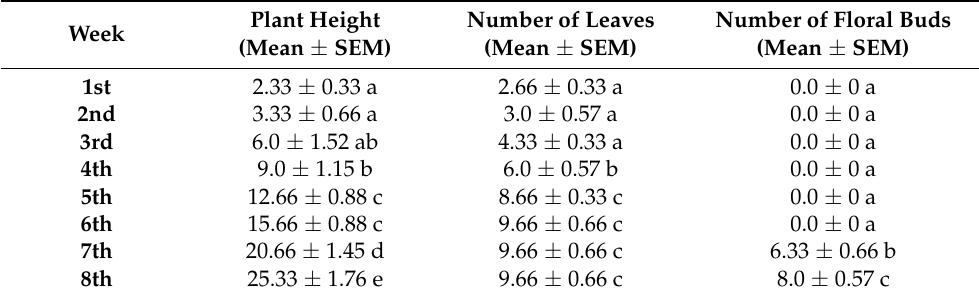
Figure 5. Hardening and acclimatization of in vitro raised plantlets of Aconitum violaceum Jacq. ex Stapf: ( A , B ) three to four week old hardened plantlets; ( C ) five to six week old acclimatized plants; ( D ) eight week old acclimatized plants. Scale bar represents 1 cm. Table 4. Morphological data of tissue culture-raised plantlets of Aconitum violaceum after acclimatiza- tion in the field.